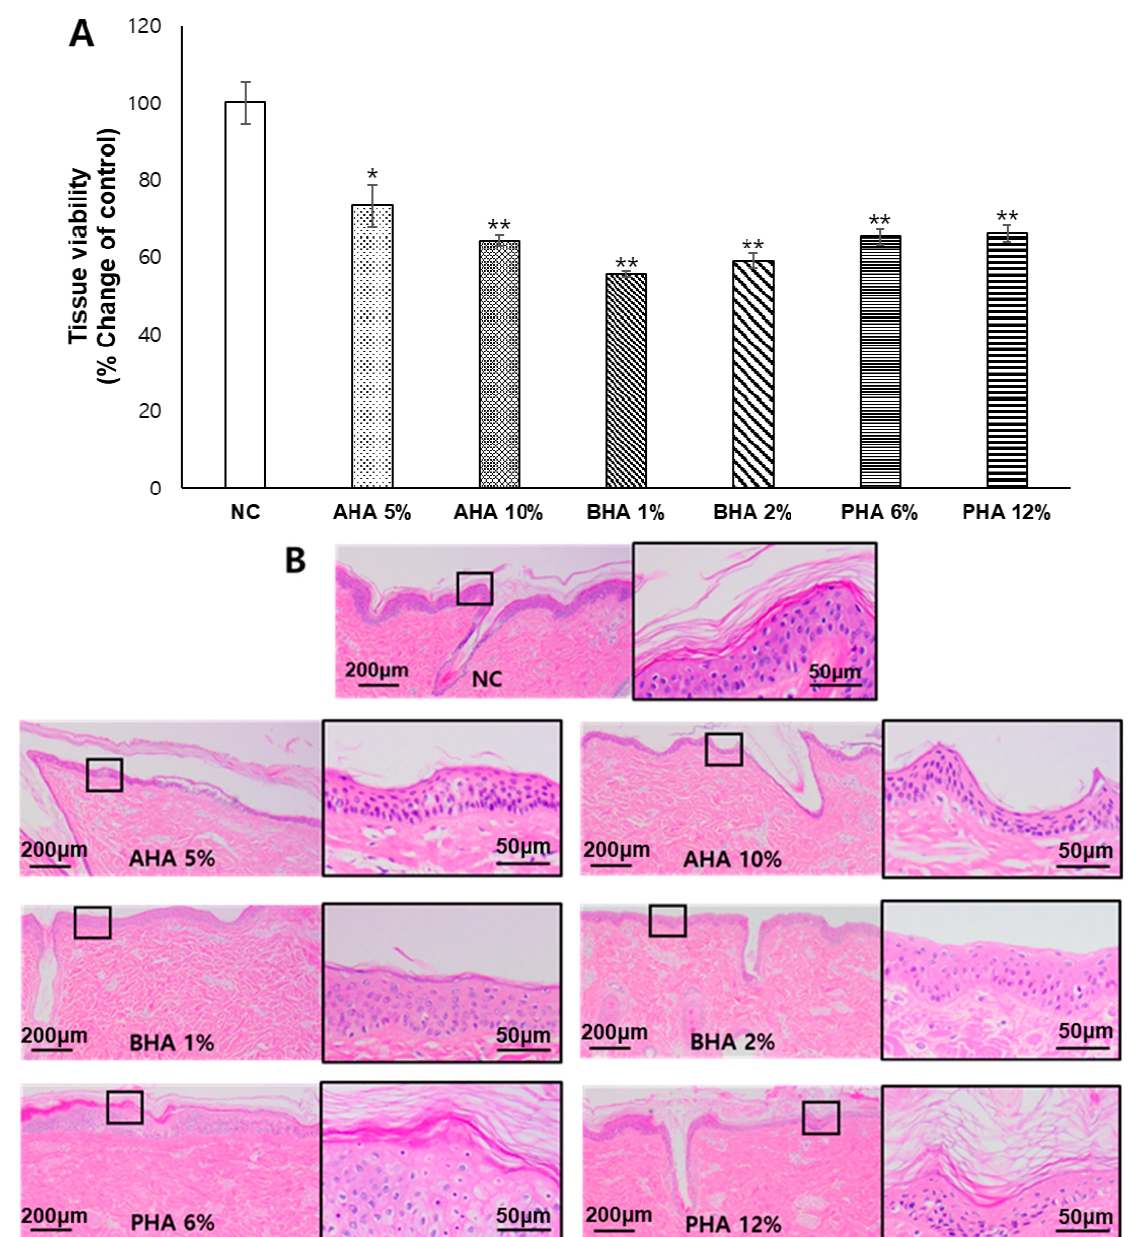
Figure 2. Damage to ex vivo porcine skin after repeated application of hydroxyacids at high concentrations Hydroxyacids were applied at high concentrations on the porcine skin every other day for six days: AHA, 5–10%; BHA, 1–2%; and PHA, 6–12%. ( A ) Tissue viability of the treated ex vivo porcine skin was determined using the WST-1 assay. Values are mean ± SE ( n ≥ 3). Significant differences are denoted by * p < 0.05 and ** p < 0.01. ( B ) Porcine skin was processed and H&E stained. A representative microphotograph is shown. NC; negative control (30% ethanol).